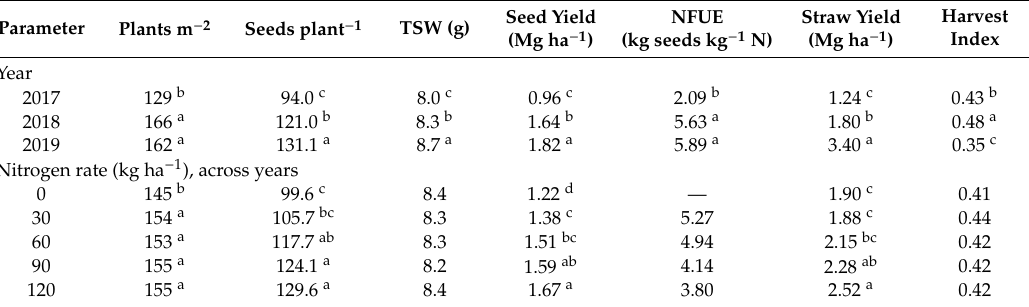
Table 4. Yield components and biomass yield of